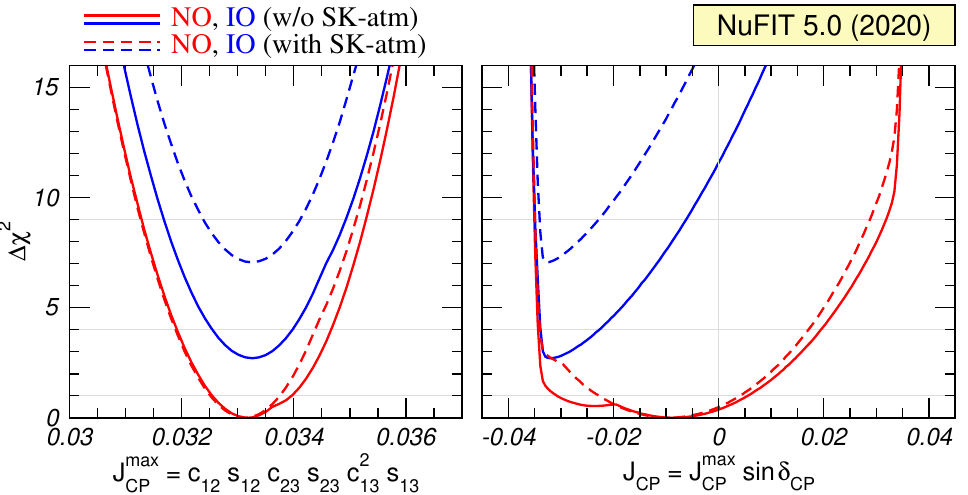
Figure 8 . Dependence of the global (cid:1) (cid:31) 2 function on the Jarlskog invariant. The red (blue) curves are for NO (IO). Solid (dashed) curves are without (with) adding the tabulated SK-atm (cid:1) (cid:31) 2